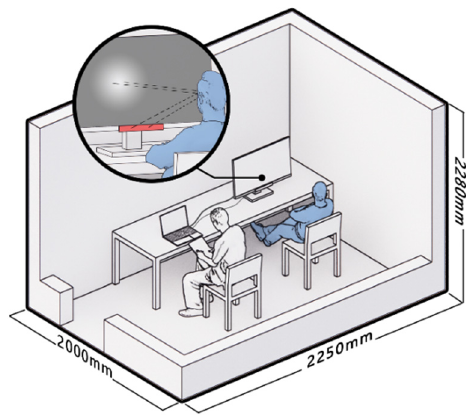
Figure 2. Experimental